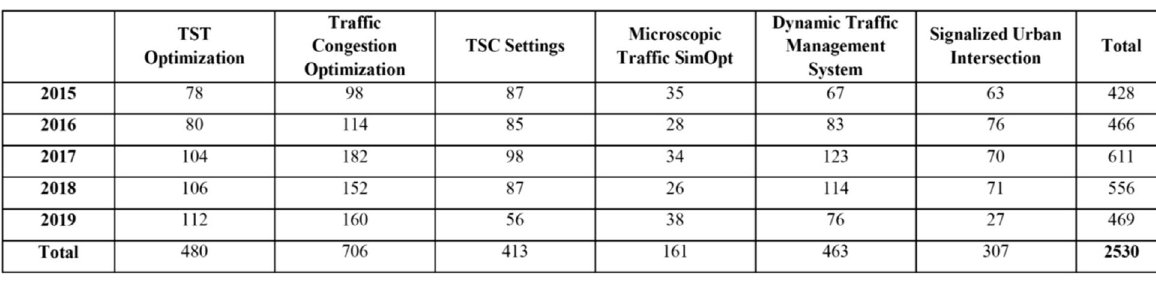
Table 2 Number of papers covering the literature review keywords per